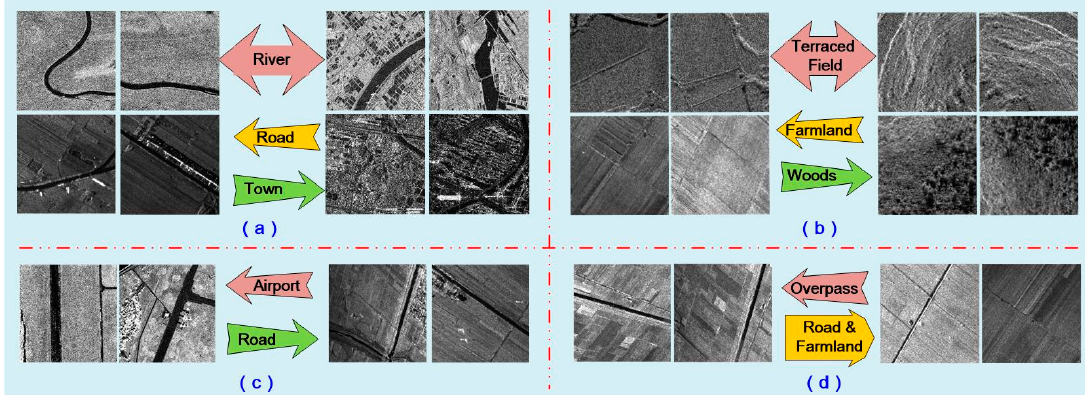
Figure 10. Some samples showing for terraced field, farmland and woods. ( a ) The looks alike scenes among Road, River and Town; ( b ) The looks alike scenes among Terraced Field, Farmland and Woods; ( c ) The look alike scenes between Airport and Road; ( d ) The look alike scenes between Overpass and Farmland.